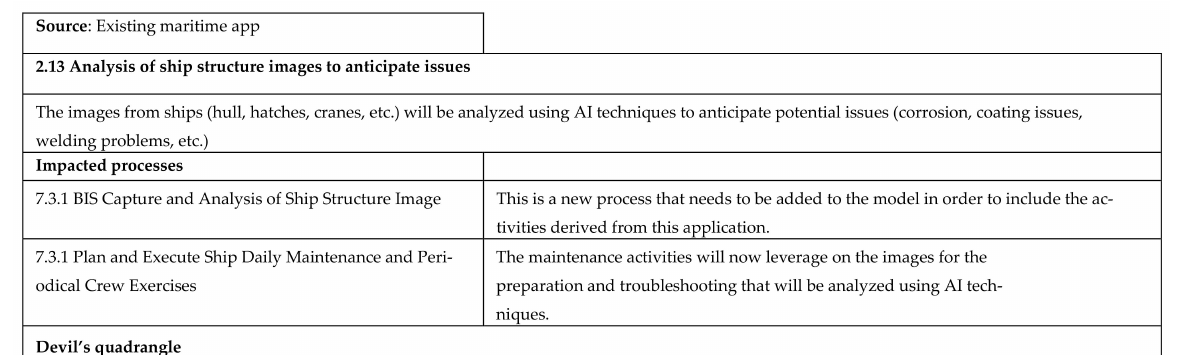
Figure A17. Cont